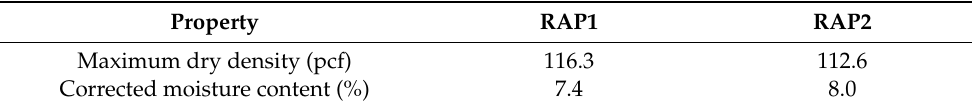
Table 4. RAP millings maximum dry density and optimum moisture